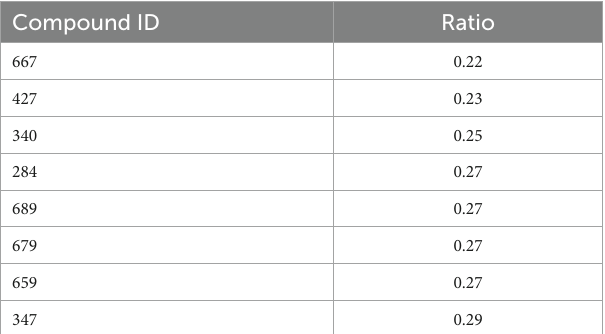
TABLE 1 Compounds that exhibited the largest decrease in the ratio of lipid A modified by